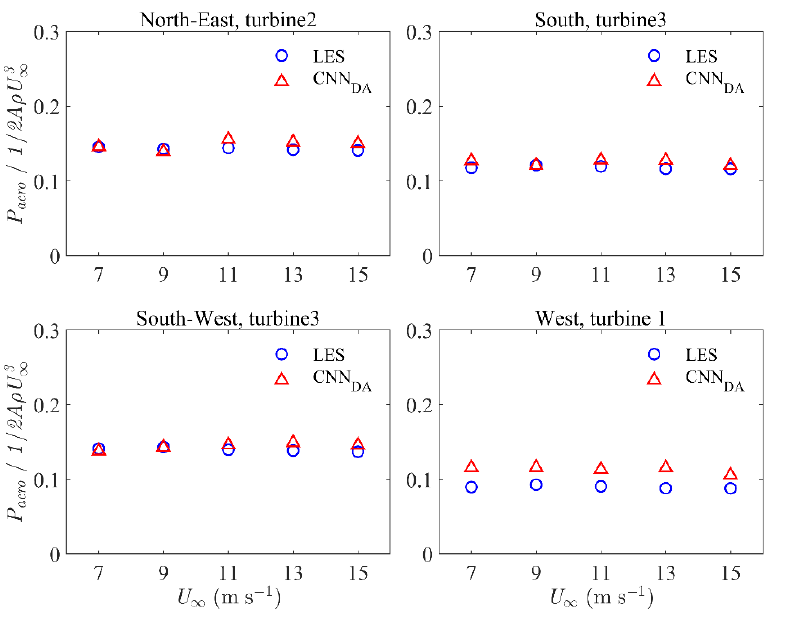
Figure 17. Power production of turbines located in the wake.